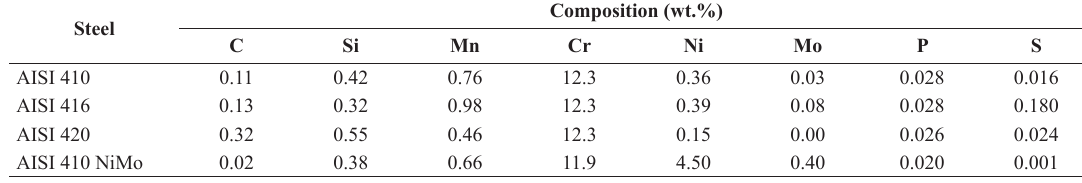
Table 1. Steel composition according to the steel manufacturer certificate.